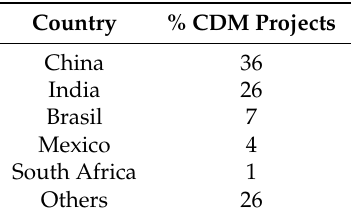
Table 5. Distribution of global clean development mechanism projects.